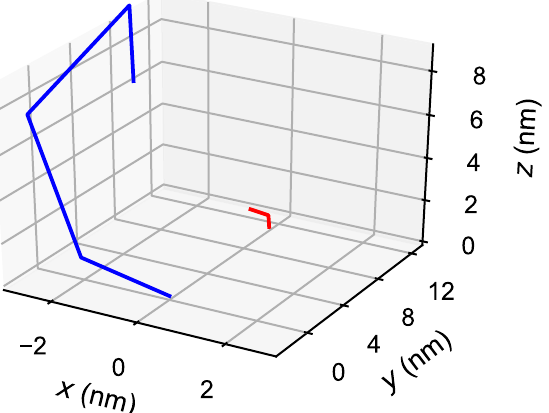
Figure 3. An example of a pair of sampled tethered structures. The H 0 structure is shown in blue and the H 1 structure is shown in red.